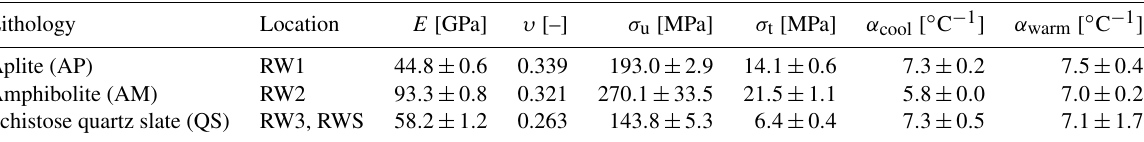
Table 1. Seismic, mechanical and thermal properties of aplite, amphibolite and schistose quartz slate. Seismic properties include Young modulus E and Poisson ratio υ ; mechanical properties include uniaxial compressive strength σ u and tensile strength σ t and thermal expansion coefficients for the cooling α cool and warming cycle α warm .